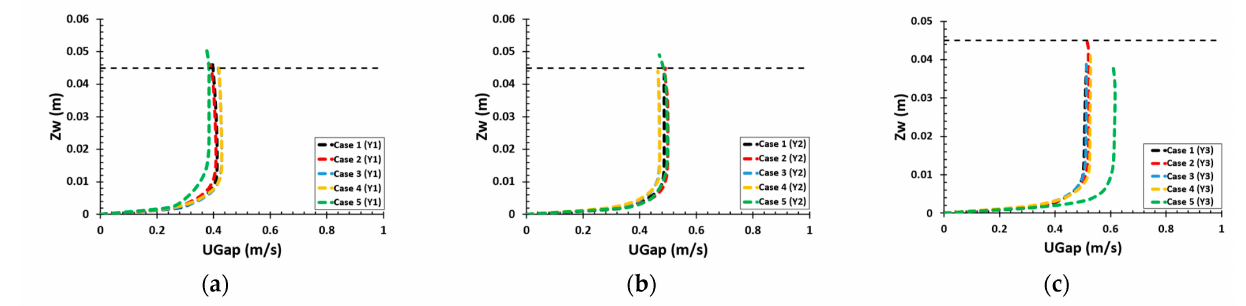
Figure 9. Vertical distribution of streamwise velocities in the gap regions at specifies locations ( a ) Y1; ( b ) Y2; ( c ) Y3. For the locations, see Figure 2. The black dashed lined shows the initial FSL.